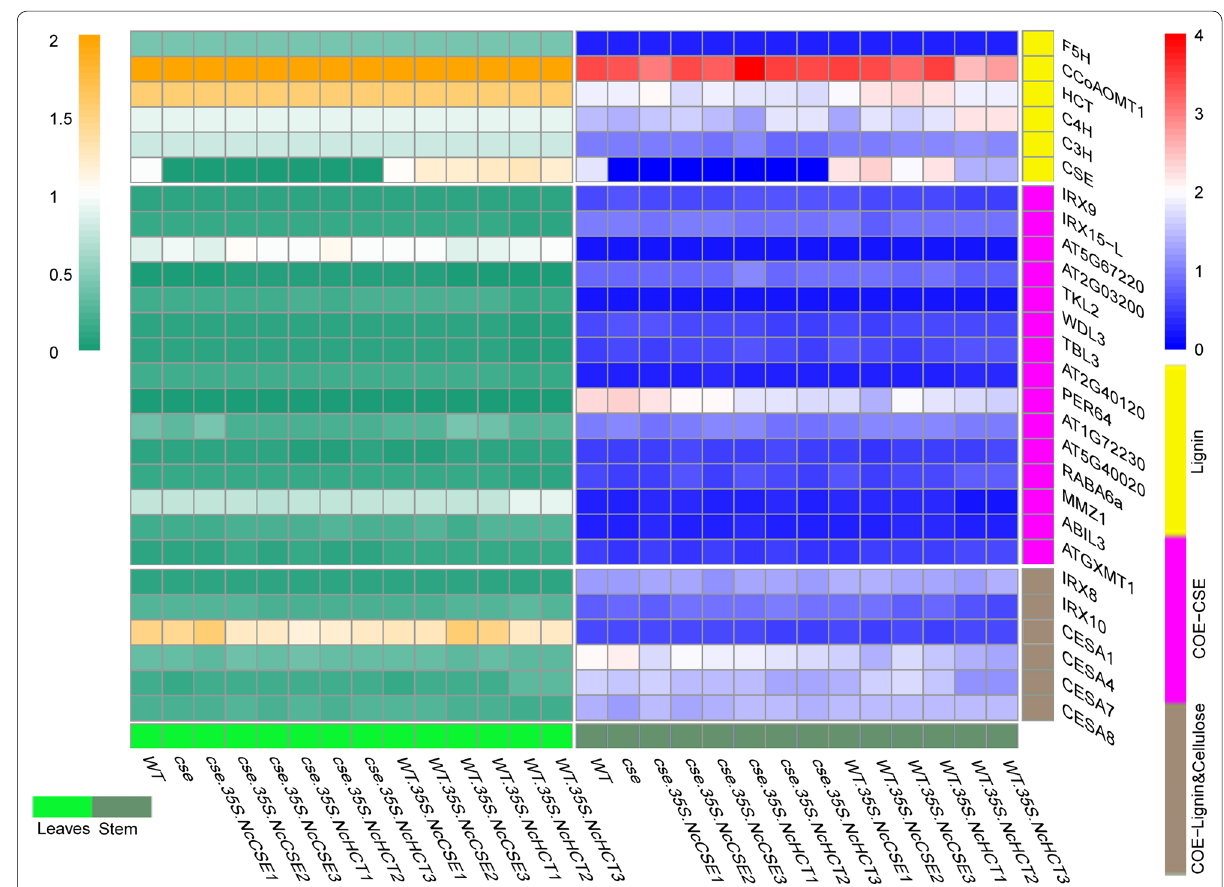
Fig. 1 Relative expression level of some A. thaliana genes relevant to the lignocellulosic biosynthesis process in different lines and